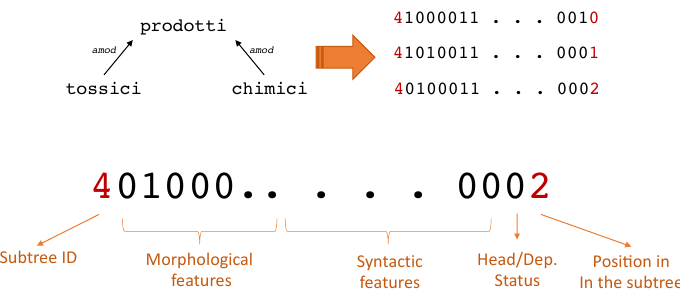
Figure 3. The conversion of a subtree into a sequence of